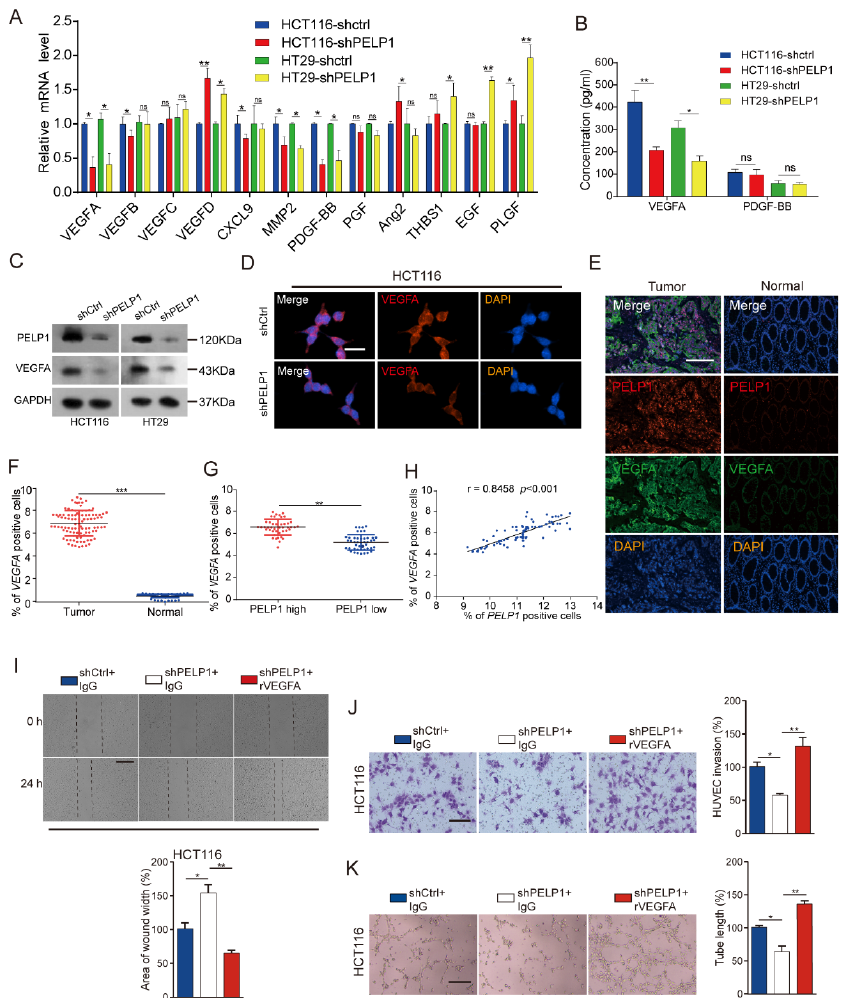
Figure 3. Down-regulation of PELP1 attenuates angiogenesis by reducing the expression of VEGFA: ( A ) The mRNA levels of the 12 angiogenesis-related genes in shCtrl cells or shPELP1 cells. GAPDH was used as an internal control. ( B ) ELISA analysis of VEGFA and PDGF-BB expression in shCtrl cells or shPELP1 cells. ( C ) Immunoblot analysis of PELP1 and VEGFA expressions in shCtrl cells or shPELP1 cells. GAPDH was used as an internal control. ( D ) Representative images of immunofluorescence for VEGFA in HCT116-shCtrl CRC cells or HCT116-shPELP1 CRC cells. Scale bar: 30 µ m. ( E ) Representative images of immunofluorescence for PELP1 and VEGFA in 90 CRC tissues and their paired normal tissues. Scale bar: 200 µ m. ( F ) Quantification of VEGFA-positive cells in CRC tissues and paired normal tissues. ( G ) Quantification of VEGFA-positive cells in PELP1 low and PELP1 high CRC tissues. ( H ) Correlation analysis between PELP1 and VEGFA in CRC tissues. ( I ) Representative images of wound healing in HUVECs treated with CM from HCT116-shCtrl CRC cells or HCT116-shPELP1 CRC cells treated with or without rVEGFA and IgG (upper panel). Scale bar: 200 µ m. Histograms with the fold change in wound closure formed by the indicated cells (lower panel). ( J ) Representative images of cells migration in HUVECs treated with CM from HCT116-shCtrl CRC cells or HCT116-shPELP1 CRC cells treated with or without rVEGFA and IgG (left panel). Scale bar: 200 µ m. Histograms with the fold change in the number of invasion cells formed by the indicated cells (right panel). ( K ) Representative images of tube formation in HUVECs treated with CM from HCT116-shCtrl CRC cells or HCT116-shPELP1 CRC cells treated with or without rVEGFA and IgG (left panel). Scale bar: 200 µ m. Histograms with the fold change in the length of tube-like formation formed by the indicated cells (right panel). Data are shown as the means of three independent experiments or representative data. Error bars indicate SD. ns: no significance, * p < 0.05, ** p < 0.01, *** p < 0.001 by Student’s t